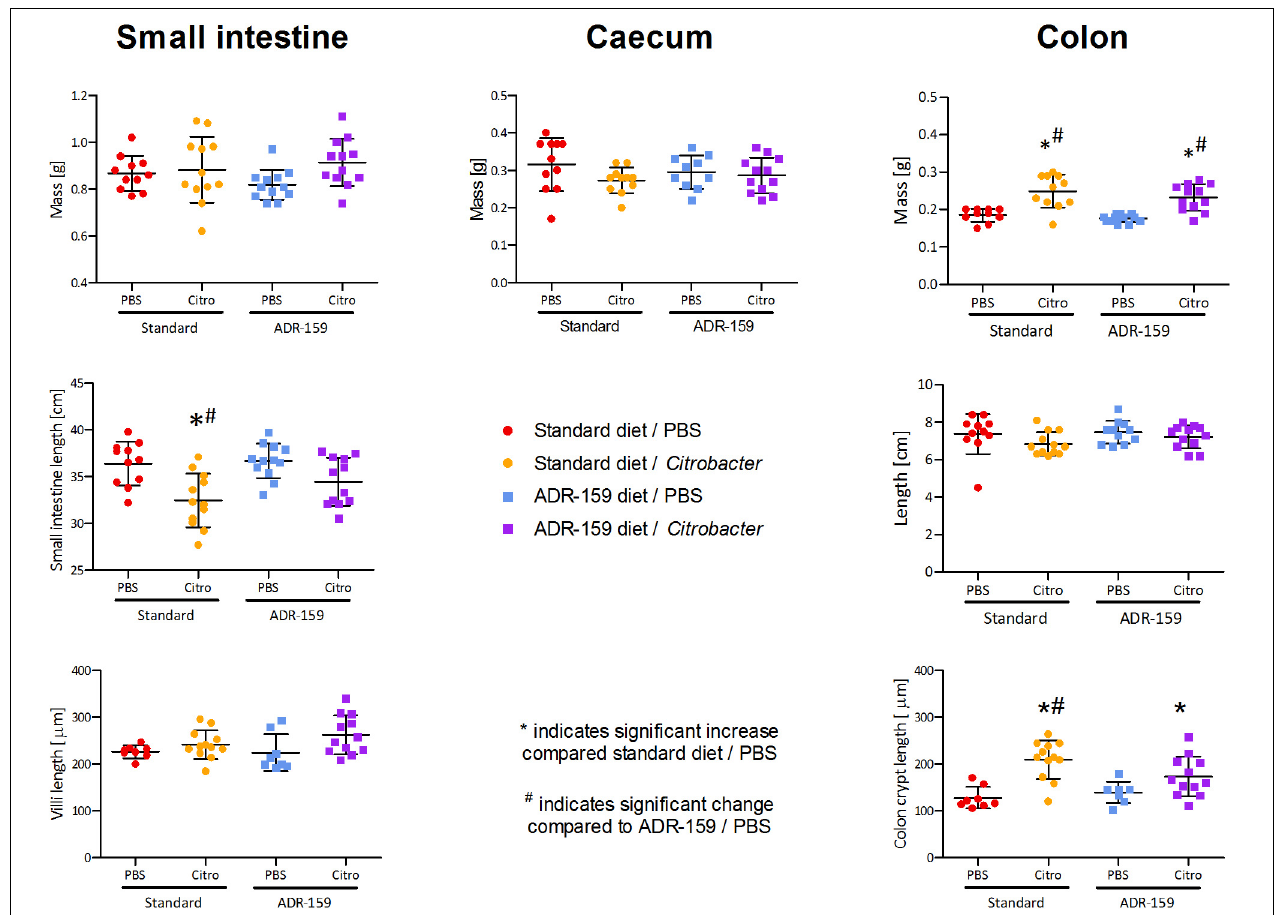
FIGURE 5 | Mass, total length, and villi/crypt length of internal organs of standard (circle) and ADR-159 (square) fed animals dosed with PBS (red, blue) or C . rodentium (orange, purple). Error bars represent SD. *Indicates significant increase compared to standard diet/PBS, # Indicates significant change compared to